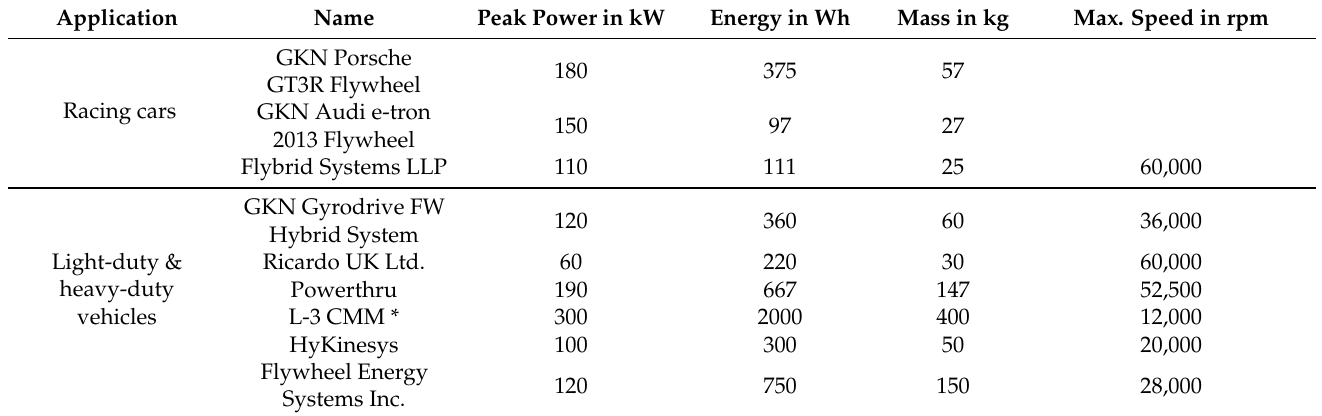
Table 1. Overview of flywheels used in racing cars and vehicles